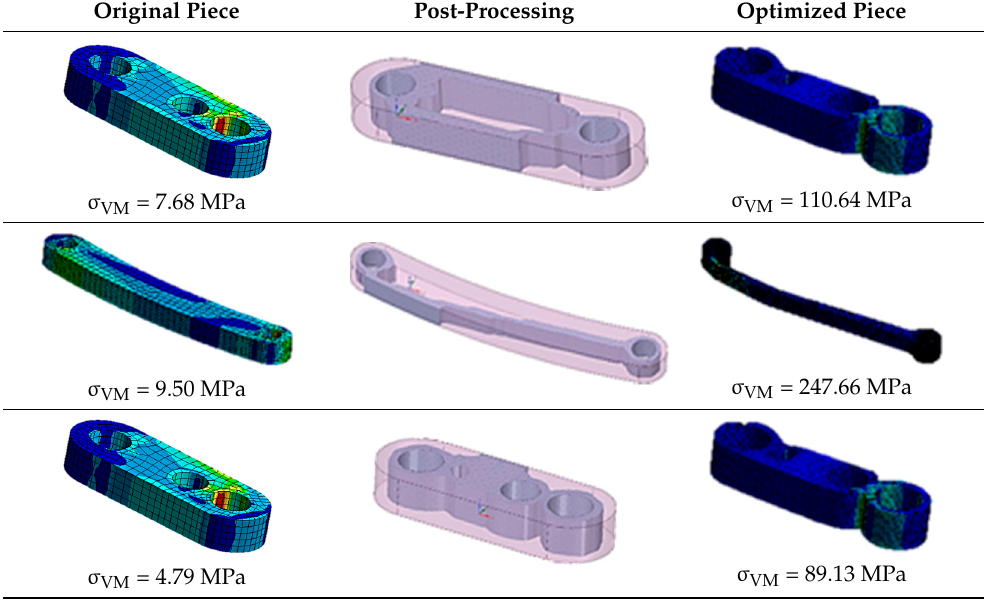
Table 6. Cont. Original Piece Post-Processing